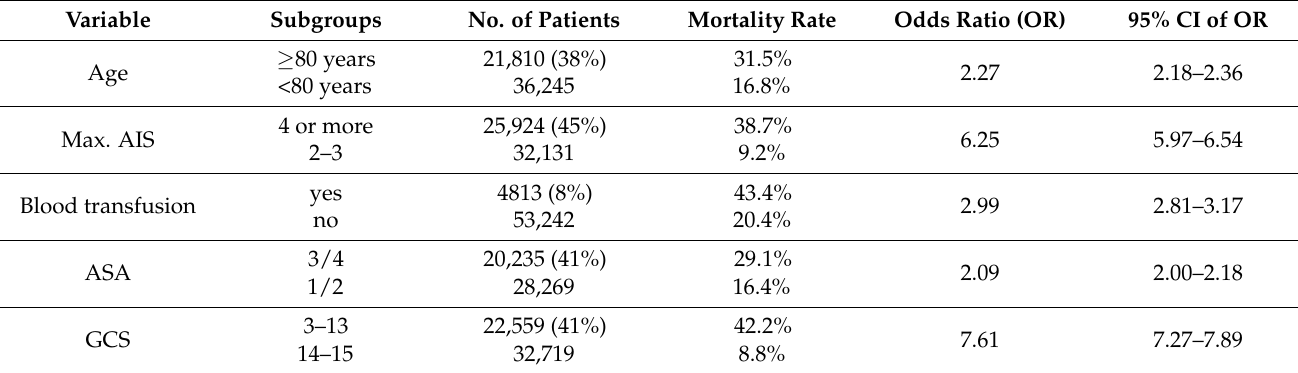
Table 2. Mortality rates and odds ratios of specific variables.